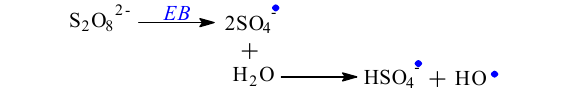
Figure 4. Possible mechanism for obtaining radicals by irradiation from water.